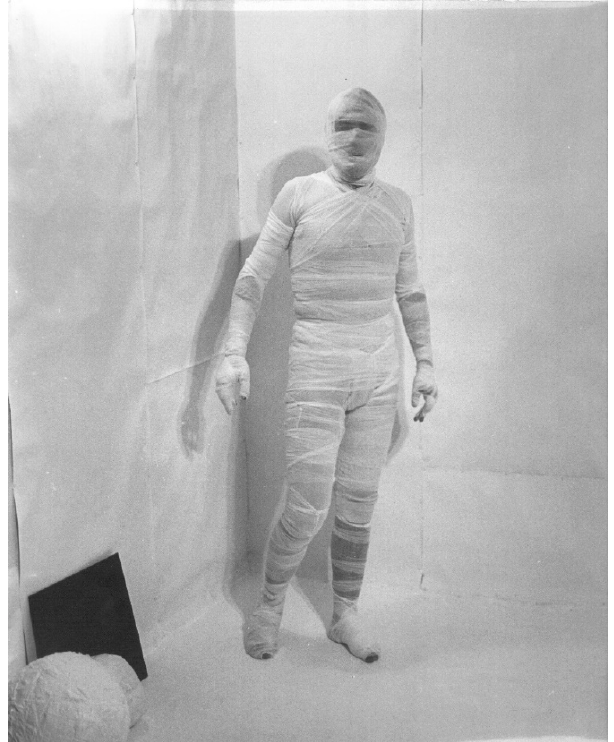
Figure 5. Rudolf Schwarzkogler, 6th Action , Vienna, 1966. © Österreichische Ludwig Stiftung/Courtesy Konzett Gallery.